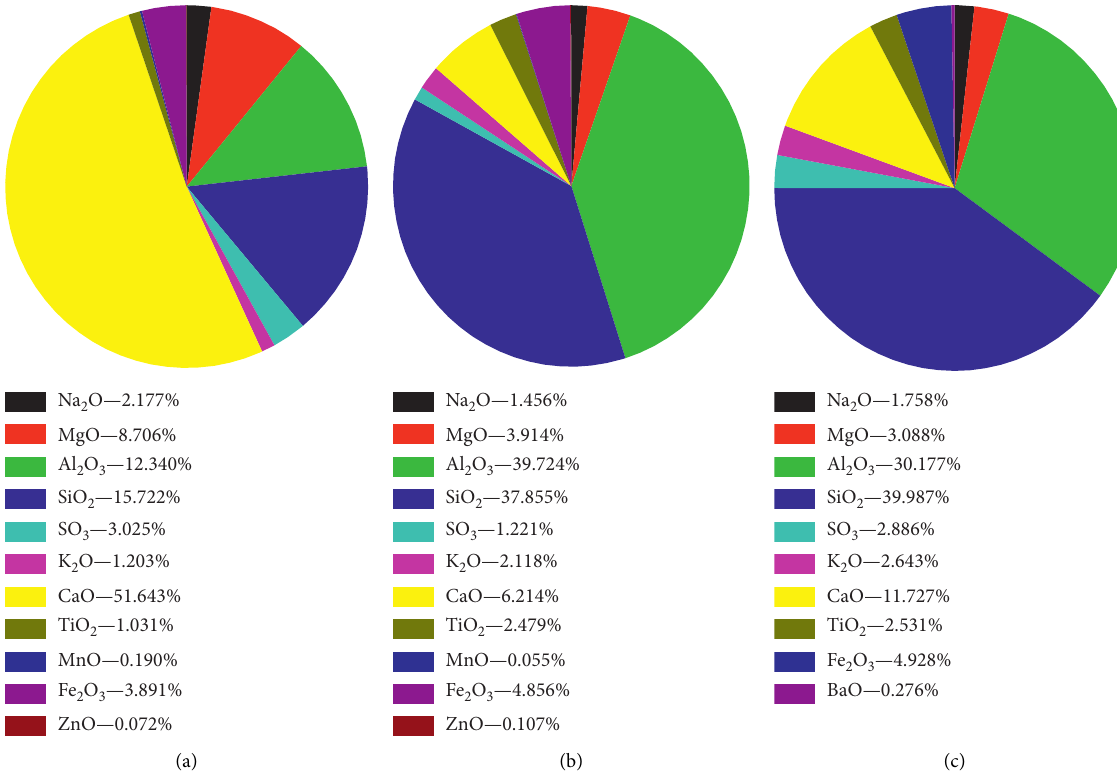
Figure 3: Mineral components of (a) cement, (b) fly ash, and (c) coal